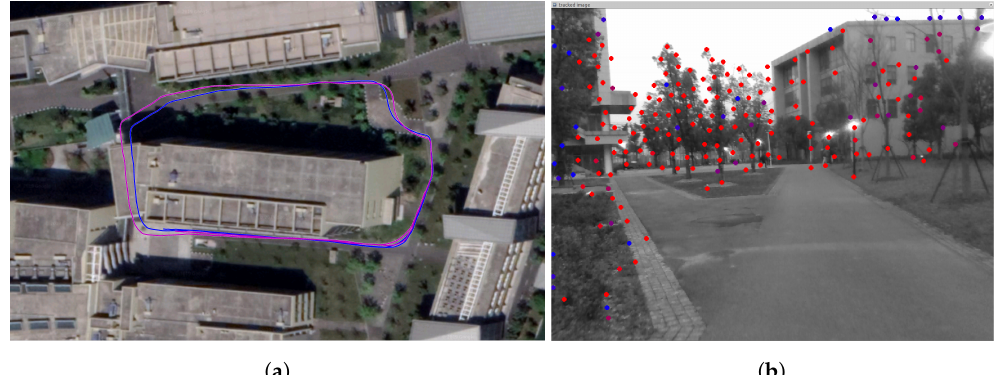
Figure 9. Open outdoor experiment. ( b ) shows a representative moment when our system is running, where the points are far away and most of them are beyond depth range of the device. The color in more red indicates the longer of tracking times. ( a ) shows the trajectories aligned to Google Maps. The blue one is estimated by our system, and the purple one is from VINS-Mono.